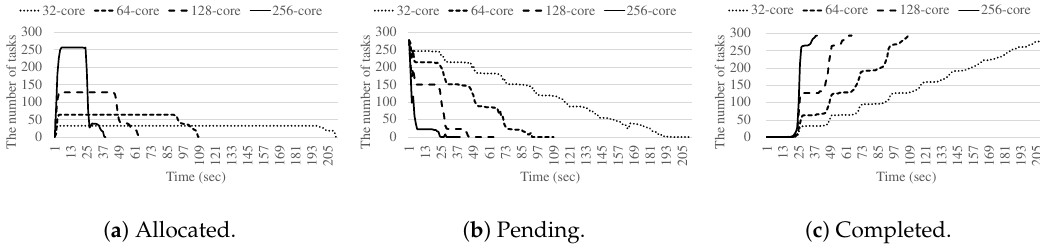
Figure 10. The number of allocated, pending, and completed tasks over time for the 470.lbm benchmark.